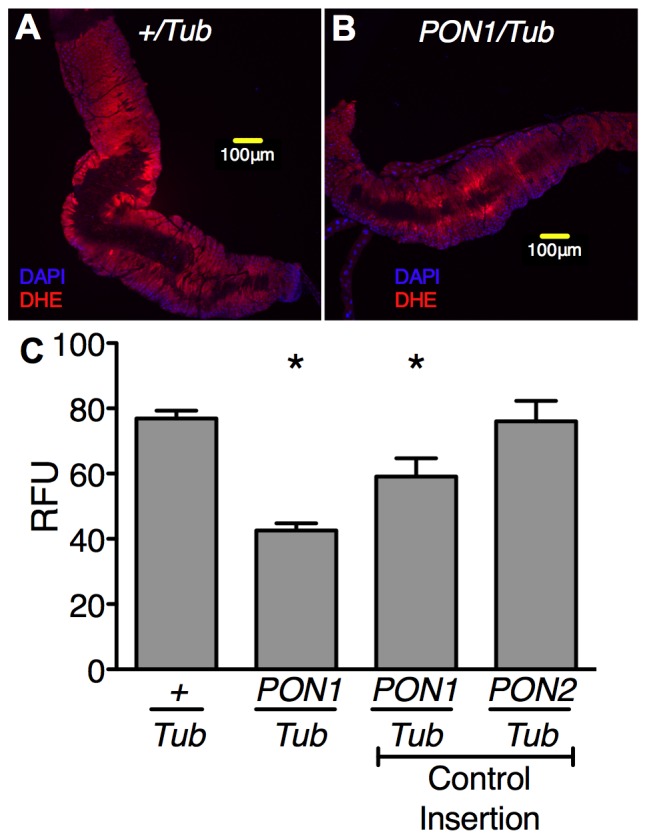
Expression of human PON1 decreases superoxide levels in the gut of D. melanogaster.(A and B) Dihydroethidium (DHE) staining and confocal microscopy were used to detect superoxide in dissected midguts from +/Tub and PON1/Tub flies. (C) Dihydroethidium staining epifluorescence intensity in midguts of +/Tub and PON1/Tub flies (P-element system insertion). Controls are PON1/Tub and PON2/Tub insertions using the phiC31 system. Data are mean ± s.e.m. n = 10 to 40 midguts per genotype. * = p<0.05 vs. +/Tub, unpaired t-test.